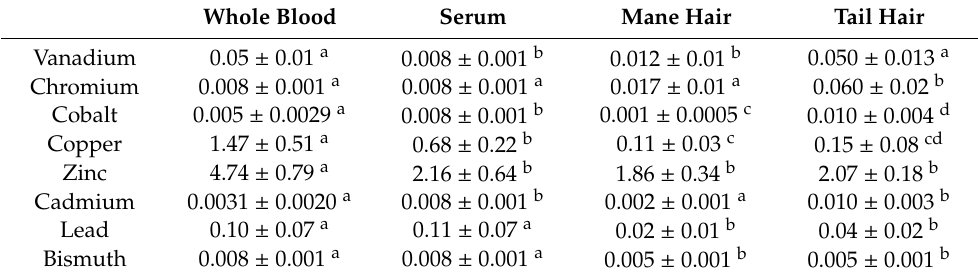
Table 2. Statistical results (mean ± SD) for the heavy metal parameters in biological component of horse. Values with di ff erent superscript ( a,b,c,d ) letter in the same row for each parameter are significantly di ff erent ( p <